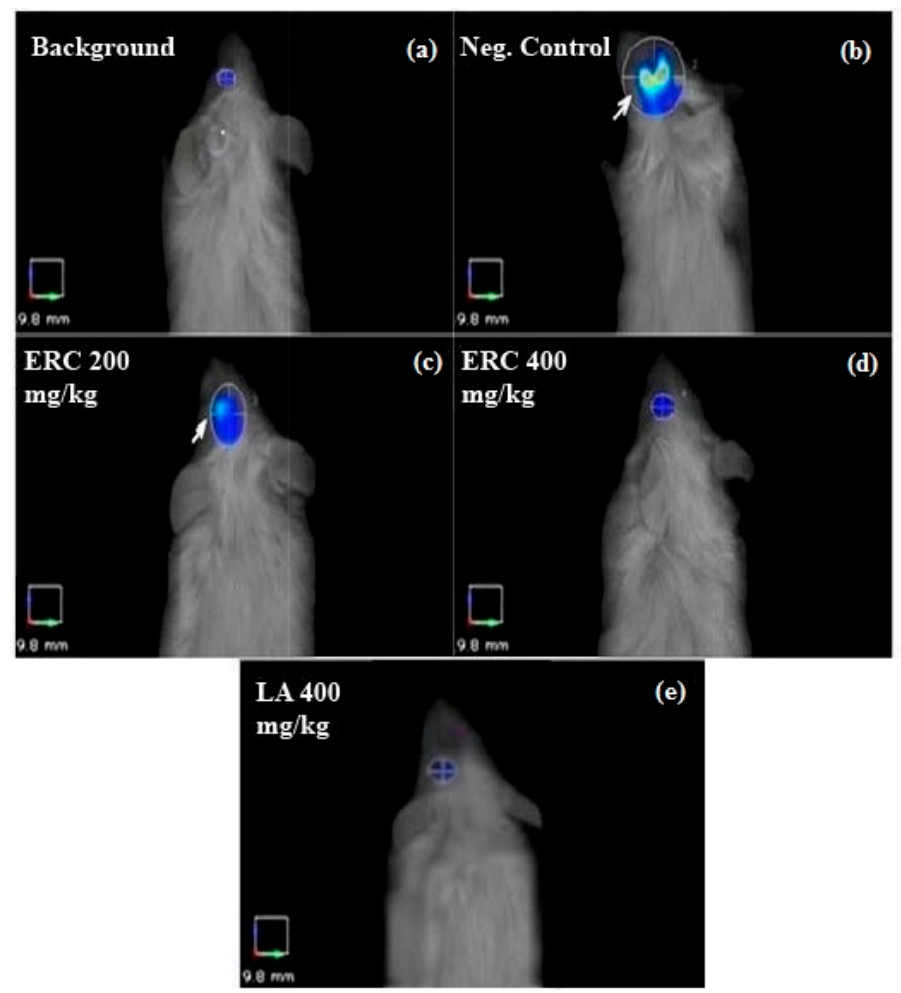
Figure 3. Fluorescence molecular tomography images with the region of interest (ROI). The ROI proximal to the eye area was selected to focus on the ischemic eye. In the negative control ( b ), the fluorescence signal was very intense (white arrow), whereas, in the treated ischemic eyes, treatment with LA ( e ) and different concentrations of ERC ( c , d ) reduced the fluorescence signal of the ROI. The image of the normal/positive control was used as the background.